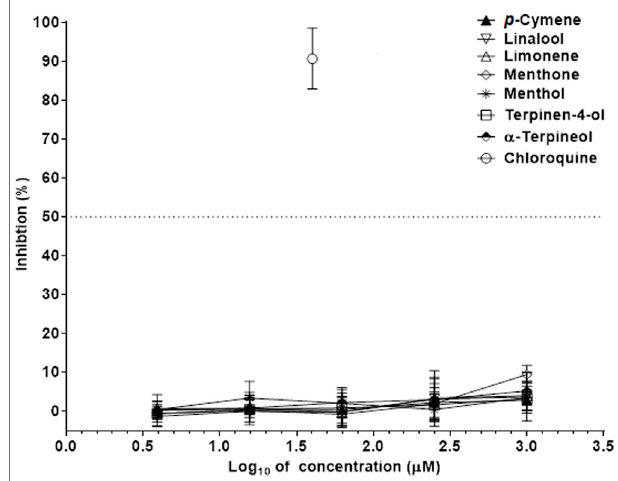
FIGURE 4 | Absence of activity against SARS-CoV-2 in p -cymene, limonene, linalool, menthol, menthone, terpinen-4-ol, and α -terpineol. The inhibition rates of SARS-CoV-2 of monoterpenes in infected Vero cells were determined in 72 h incubation assays. Chloroquine was used as a reference antiviral compound. Datapoints represent the means (±SD) of three independent biological replicates with three technical